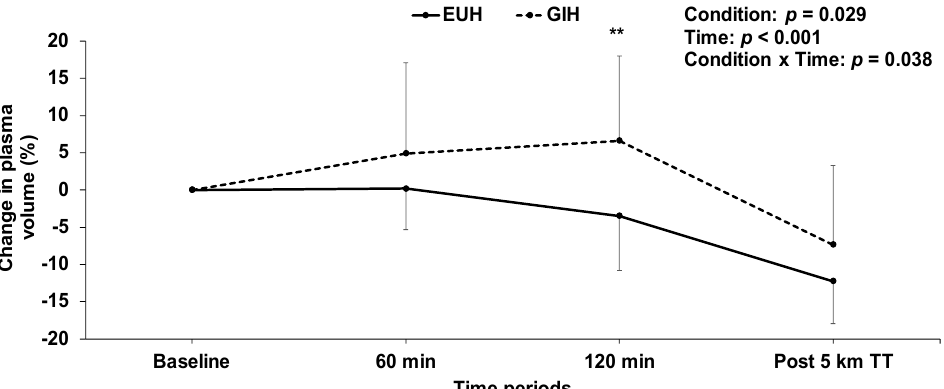
Figure 2. Effect of EUH and GIH on accumulated fluid retention during the hydration periods. *** p < 0.001 compared with EUH. EUH = euhydrated; GIH = glycerol-induced hyperhydration.